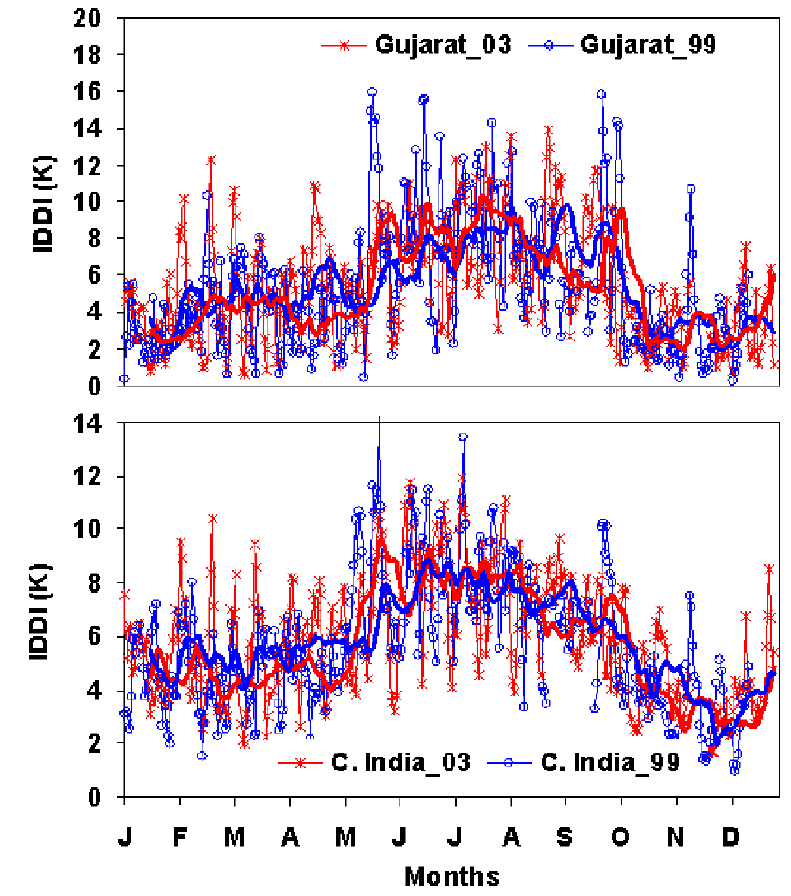
Fig. 22. Temporal variation of IDDI (K) (dashed lines) for 1999 (blue) and 2003 (red) over Gujarat and central